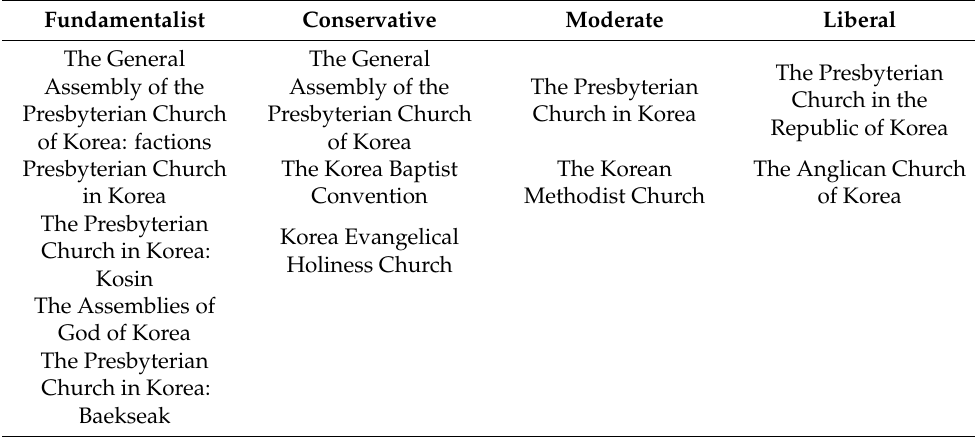
Table 5. Types of Protestant denominations in South